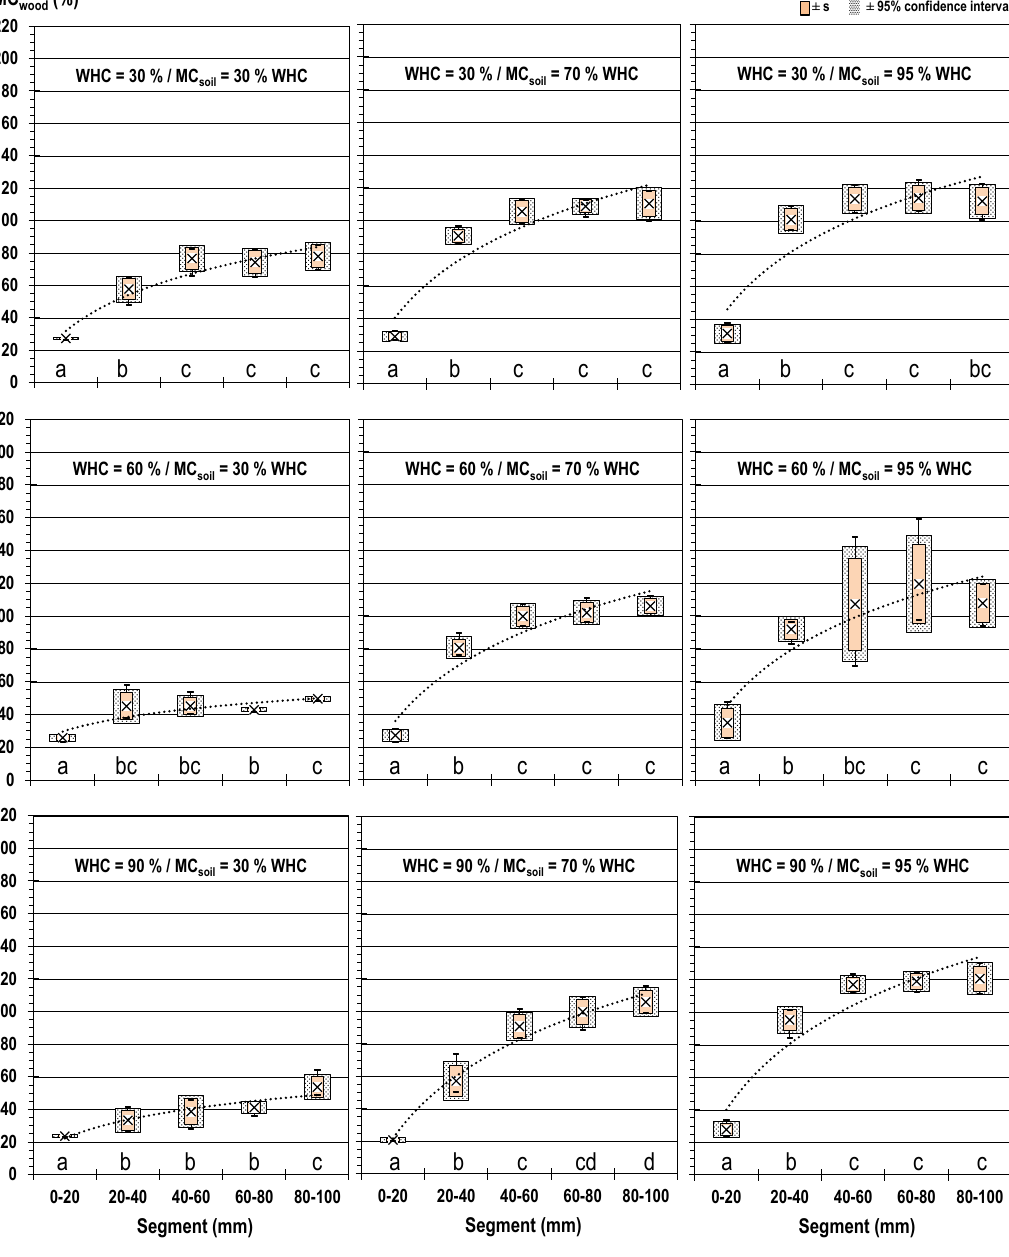
Figure 6. Distribution of MC wood in English oak specimens buried to 4/5 of their length (20 – 100 mm) in different TMCs. Different letters indicating significant differences between groups at p < 5% according to a Student t -test for non-paired samples.